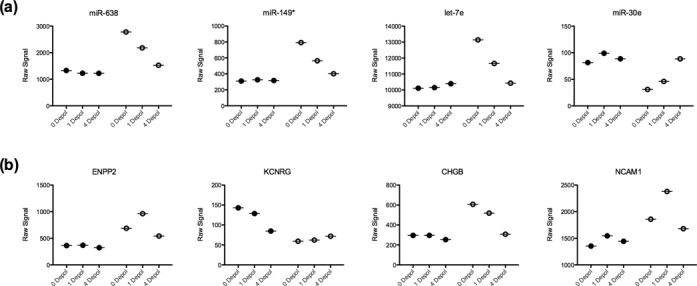
Different subcellular miRNA and mRNA responses to depolarization. Microarray data were analysed by two-way ANOVA on compartment and depolarization pattern to investigate the subcellular response to depolarization. (a) miRNA showed little response to depolarization in the cell bodies, however there were clear up- and down- regulation patterns in the neurites. (b) Comparatively, mRNA expression followed no consistent pattern in either fraction with successive depolarizations. Closed circles represent cell body samples; open circles represent neurites. 0 depol, 1 depol and 4 depol indicate resting, single depolarized and 4 sequential depolarized cells, respectively.